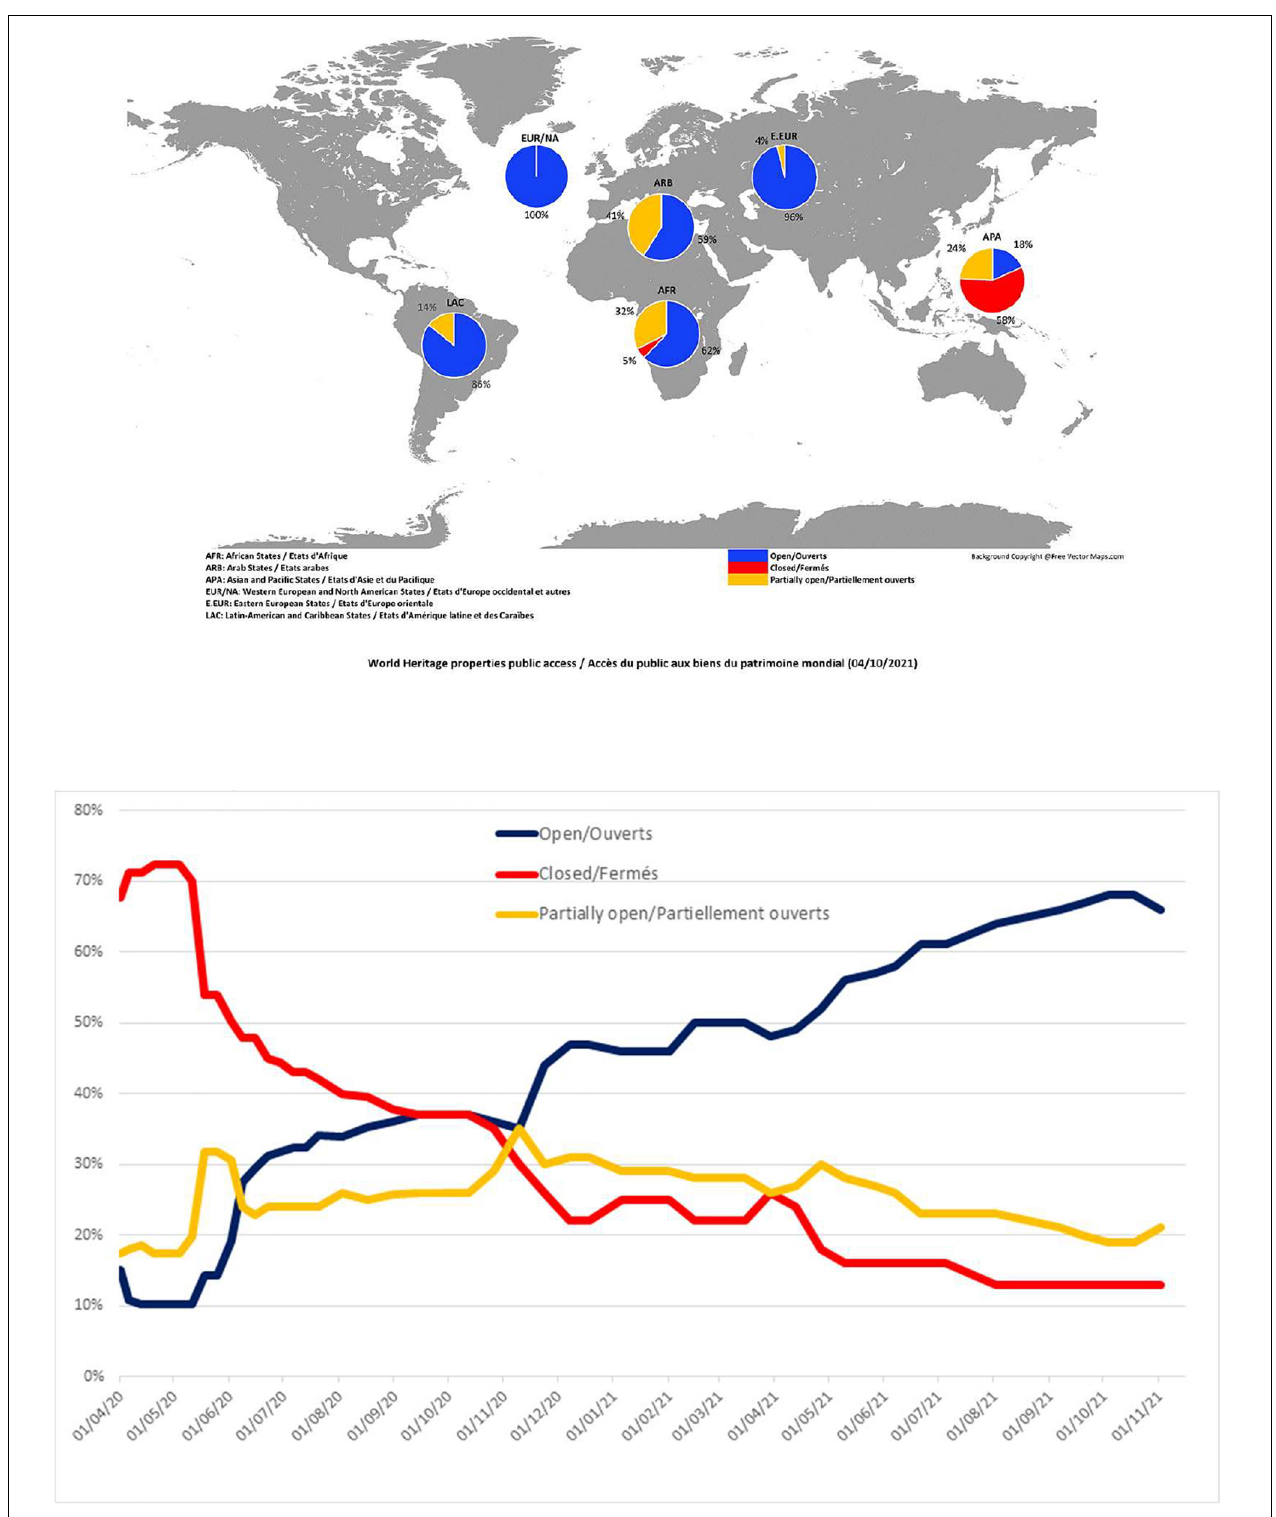
FIGURE 1 | The operating states of world heritage sites in a global scope. Sources from: https://en.unesco.org/covid19/cultureresponse/monitoring-world-heritage- site-closures.